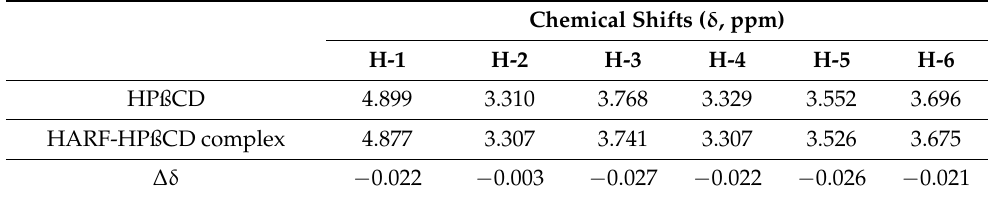
Table 1. The chemical shifts (ppm) of HP β CD before and after forming the HARF–HPßCD